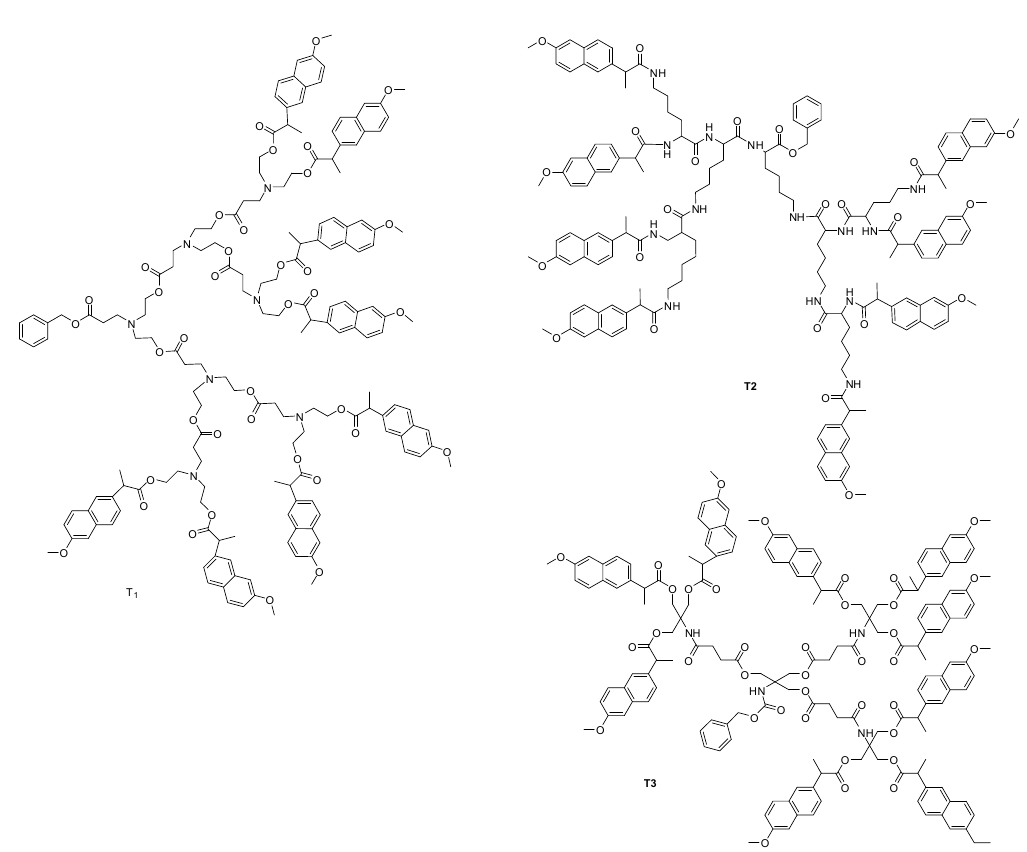
Figure 10. Potentially anti-inflammatory dendrimer prodrugs [56].